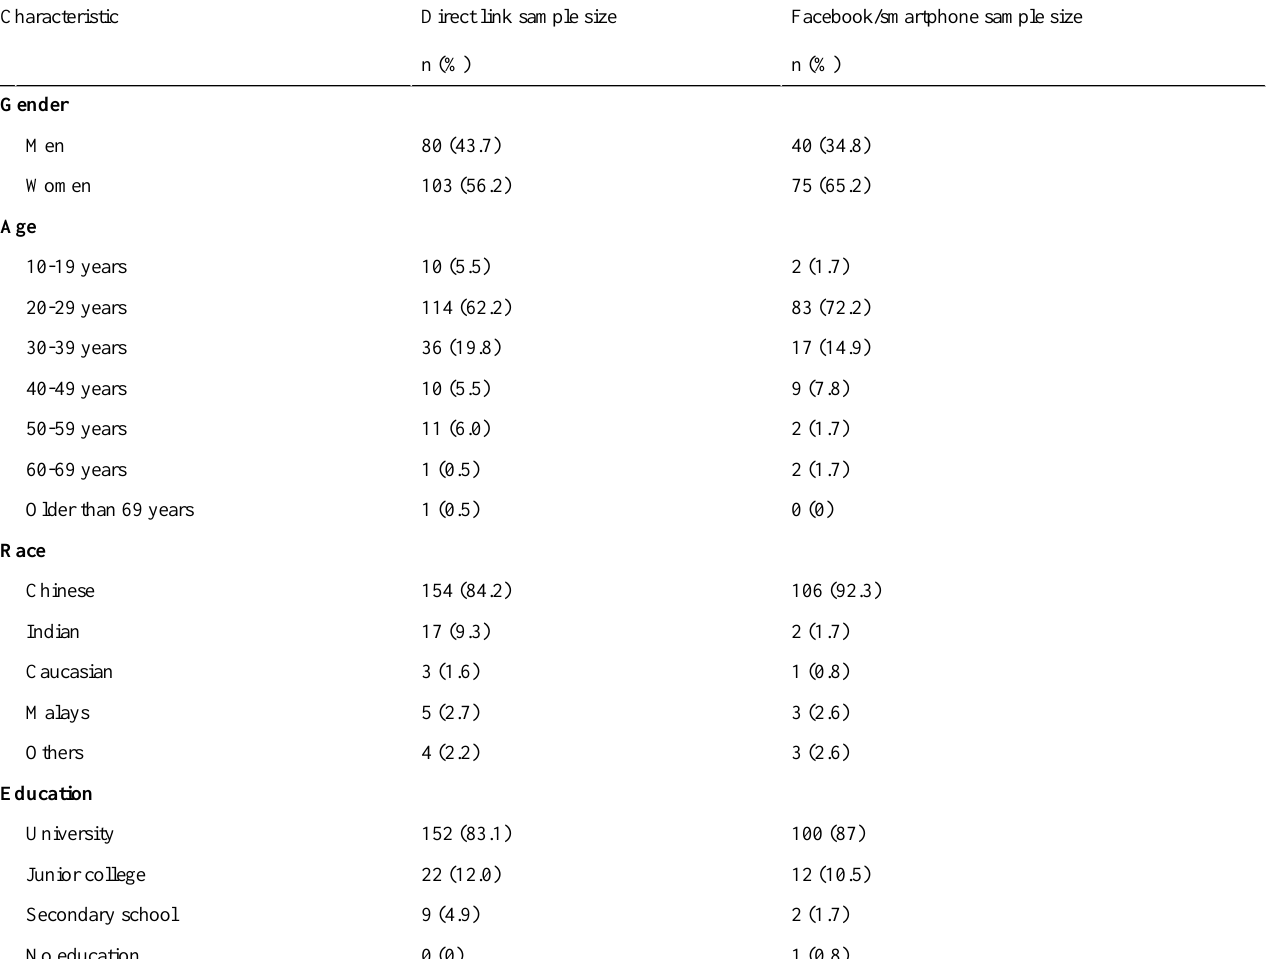
Table 2. Demographic characteristics of respondents who accessed the questionnaire directly compared with those who accessed via Facebook or